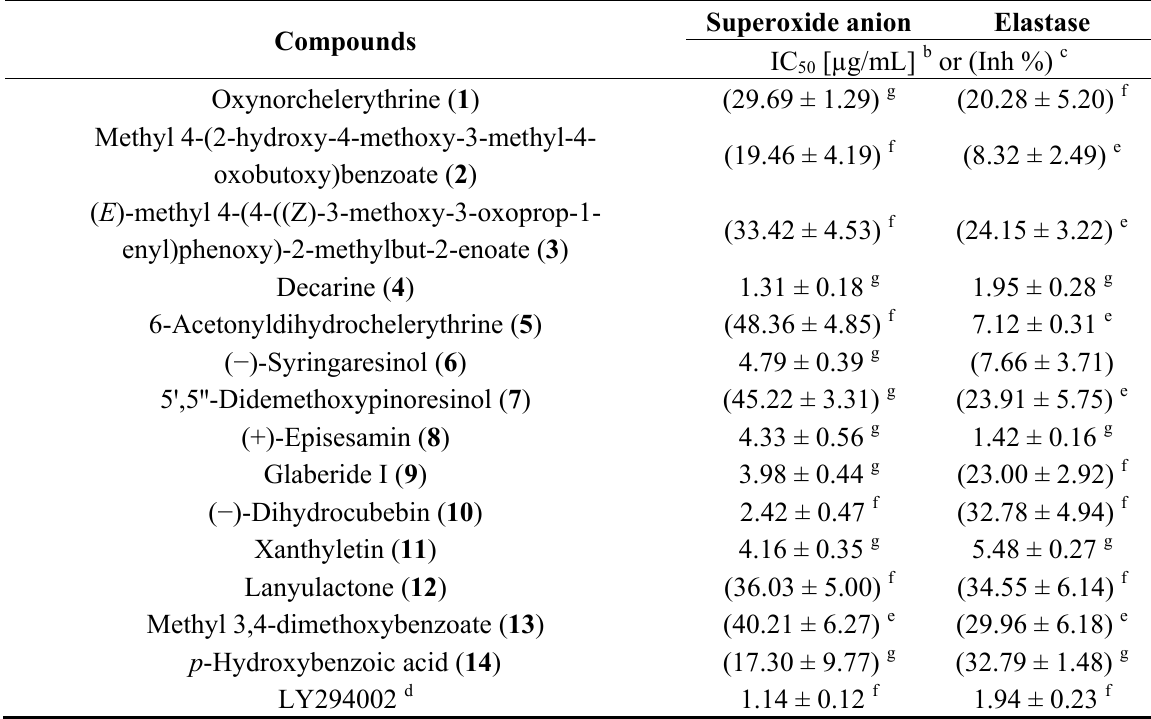
Table 2. Inhibitory effects of compounds 1 – 14 from the twigs of Zanthoxylum ailanthoides on superoxide radical anion generation and elastase release by human neutrophils in response to fMet-Leu-Phe/cytochalasin B a